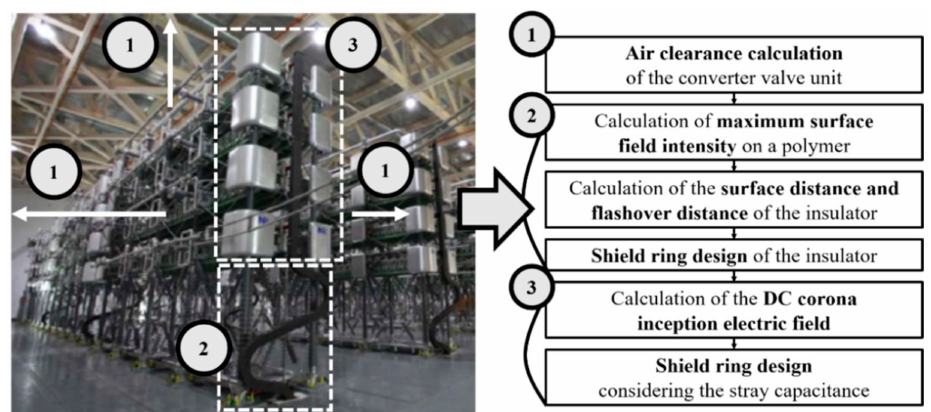
Figure 1. Insulation design process of the HVDC converter valve